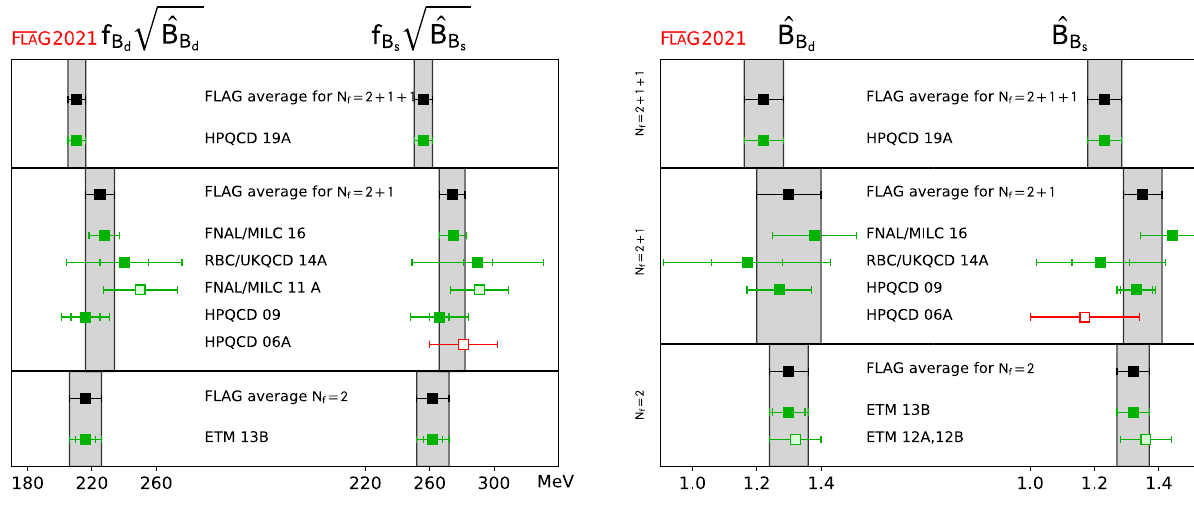
Fig. 29 Neutral B - and B s -meson mixing matrix elements and bag parameters [values in Table 43 and Eqs. (227), (230), (233), (228), (231),